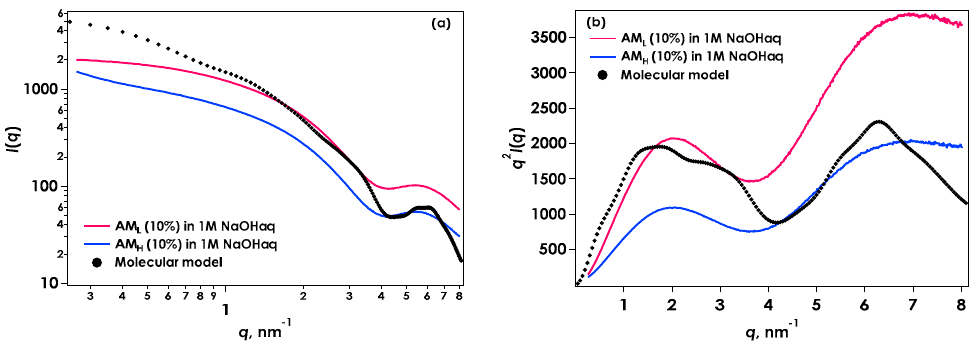
Figure 2. ( a ) Small-angle X-ray scattering (SAXS) from AM L and AM H in 1 M NaOH aq. The scattering curve calculated from the molecular model is also shown; ( b ) Kratky plots [ q 2 I ( q ) vs. q ] for SAXS data.